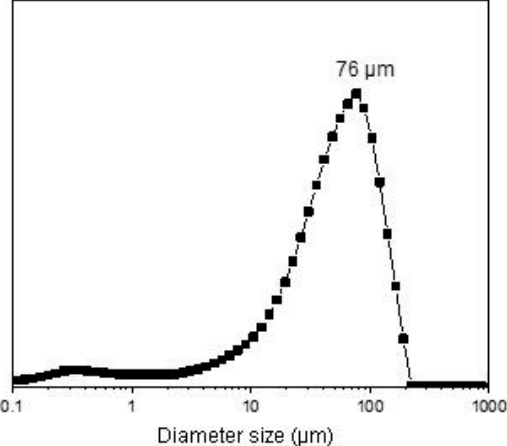
Figure 5. Kraft lignin particle size distribution.